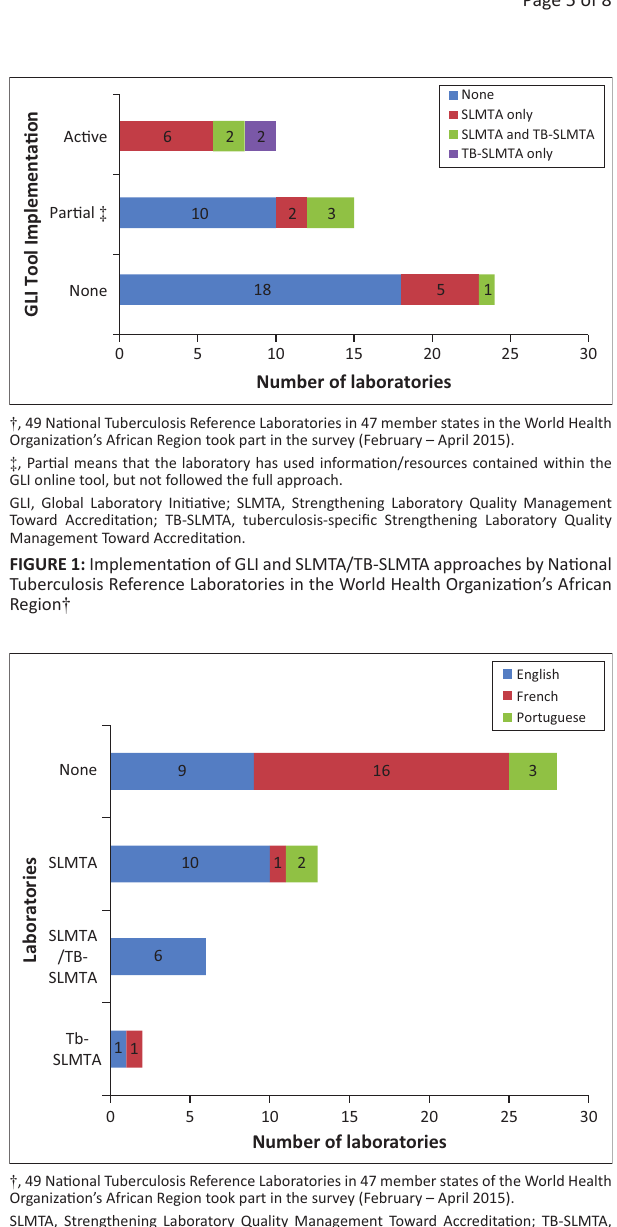
FIGURE 2: National Tuberculosis Reference Laboratories in the World Health Organization’s Africa Region † whose staff participated in SLMTA/TB-SLMTA training, according to country survey response language.